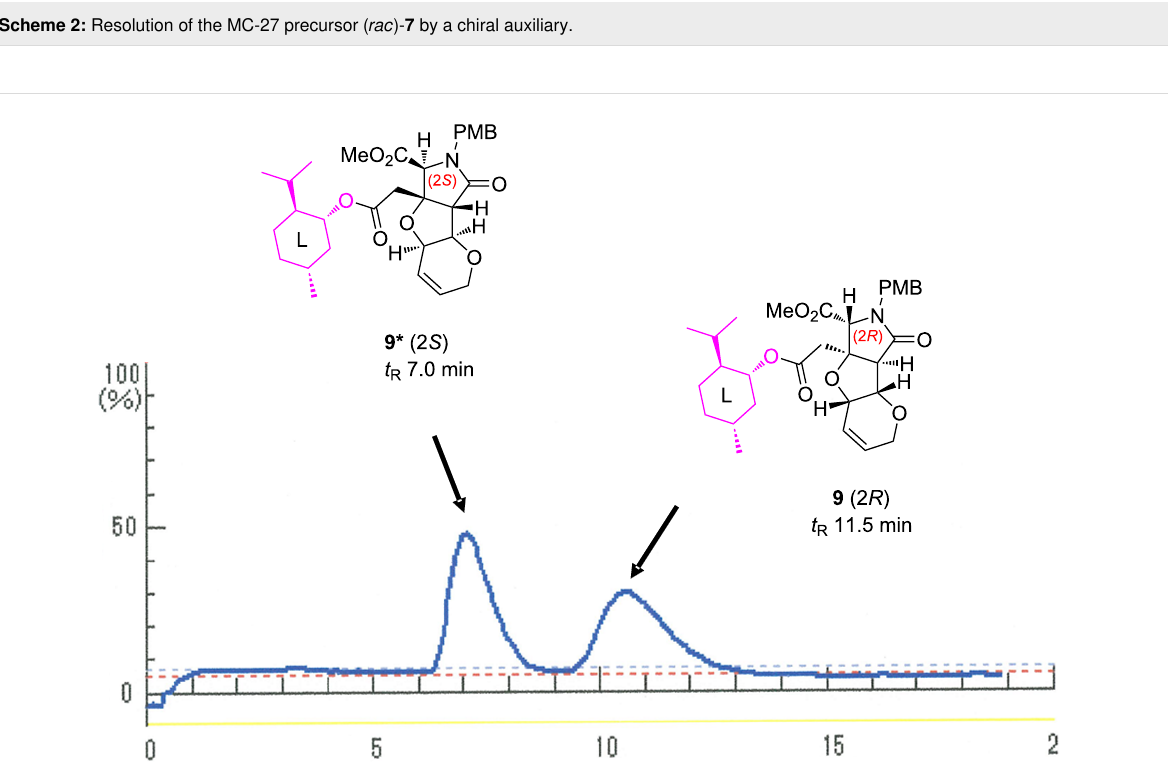
Figure 2: Chiral chromatography profiles for the separation of menthyl ester diastereomers 9 and 9* . Conditions: 30 × 100 mm CHIRALFLASH IC column, EtOH/hexane 65:35, 20 mL/min, 25 °C, 254 nm, t R 7.0, 11.5